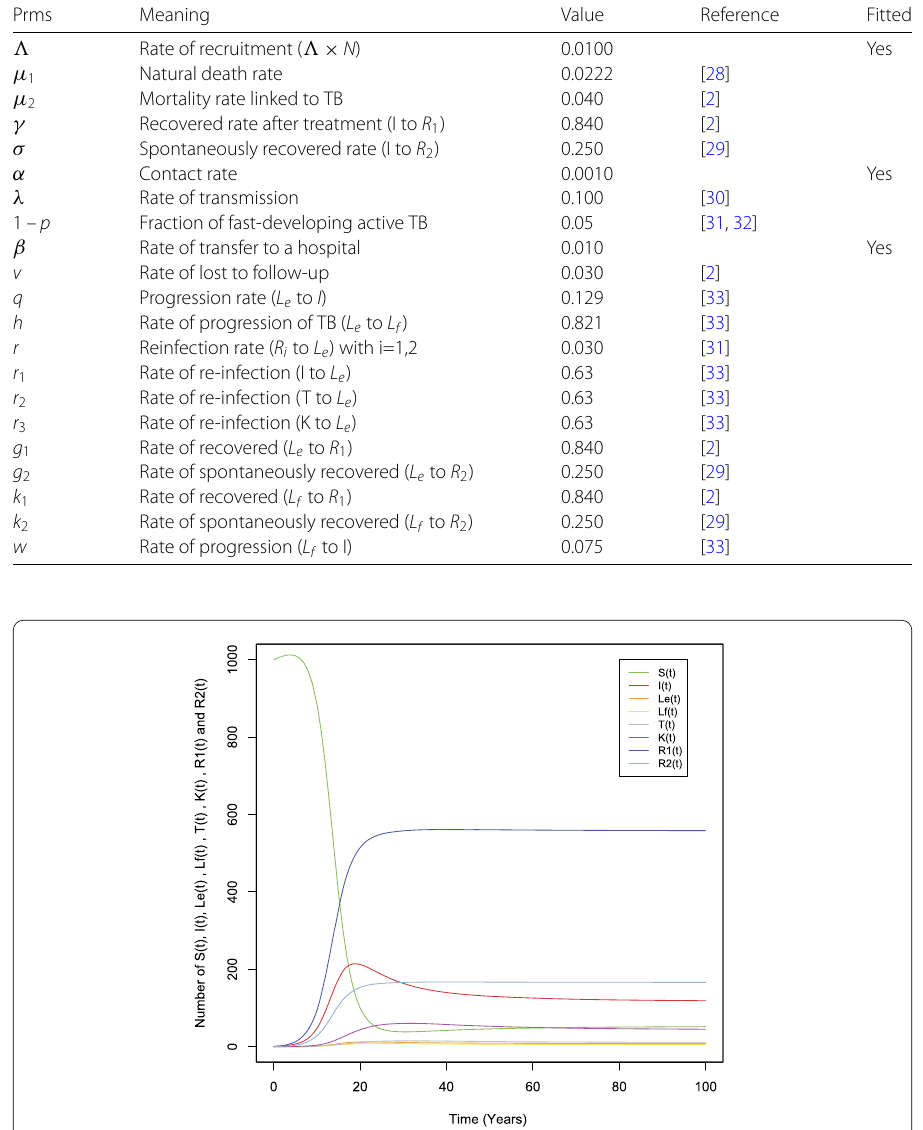
Figure 2 Evolution of the model for several years and endemic equilibrium stability using parameters presented in Table 1 with R 0 > 1. Simulation of the model for R 0 = 3.99347 and S = 1000,